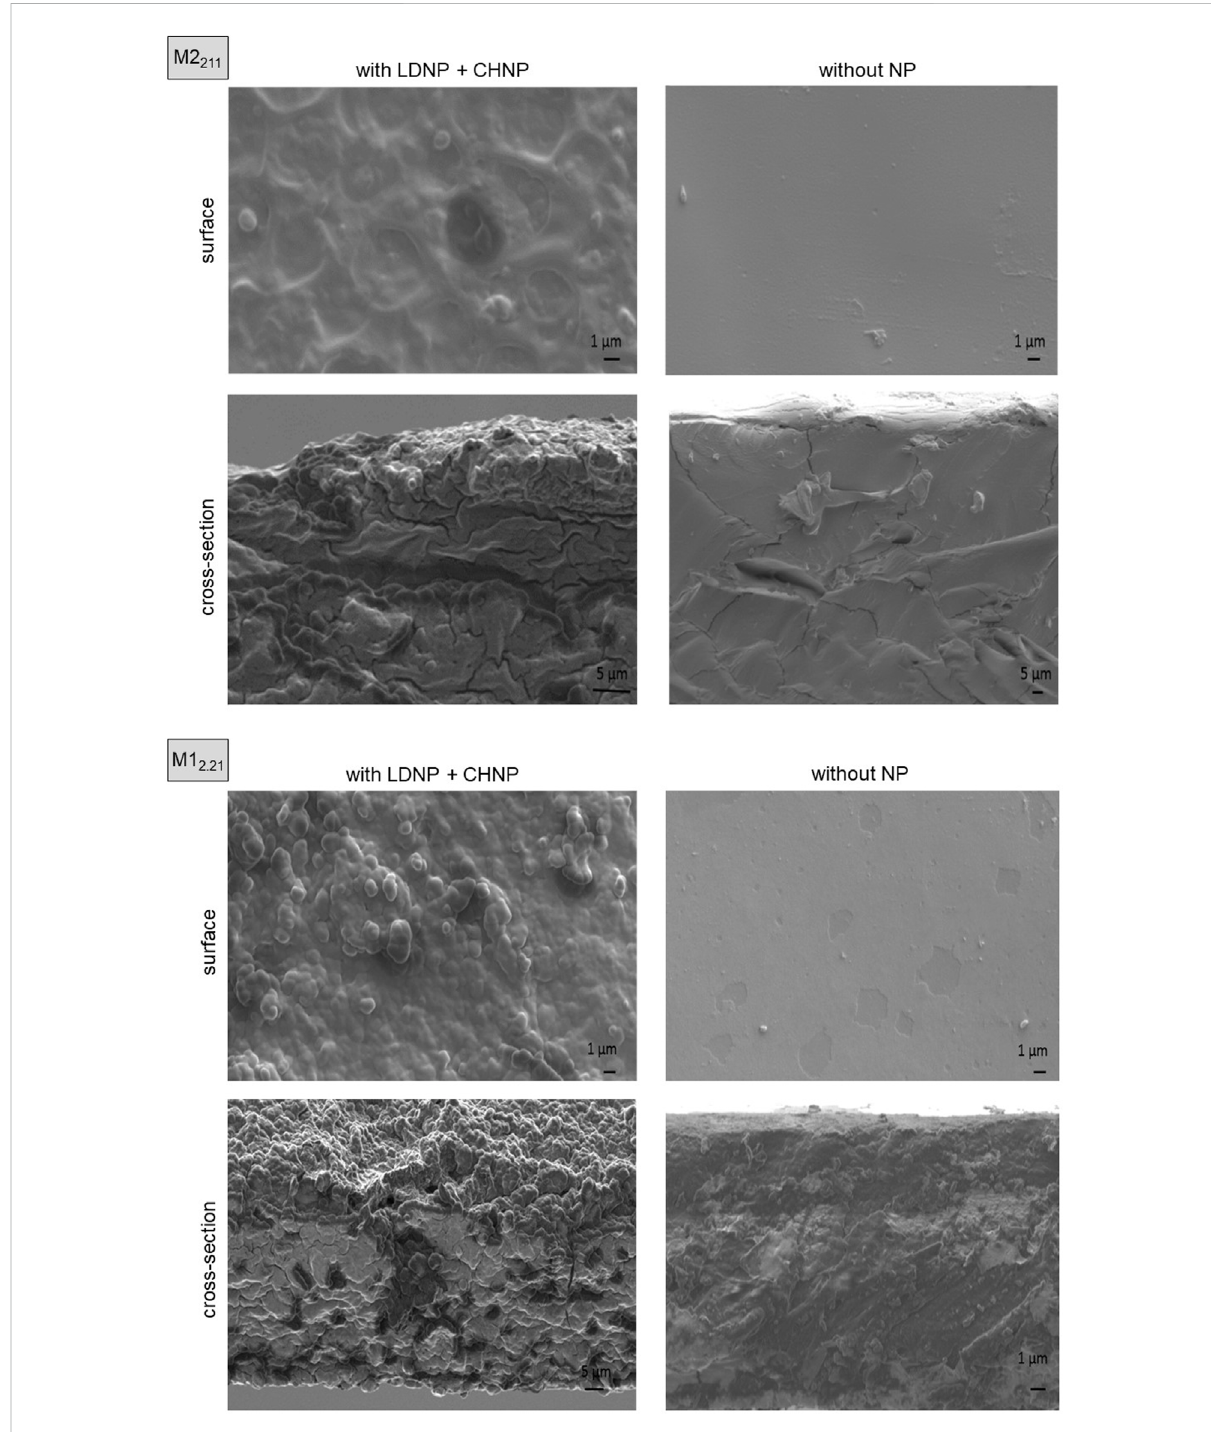
FIGURE 2 Biomembranes morphology. Surface and cross-sectional scanning electron micrographs taken from chitosan/hyaluronic acid/glycerol (CS/ HA/GL) representative membranes M1 2.21 and M2 211 , either with or without embedded LDNP and